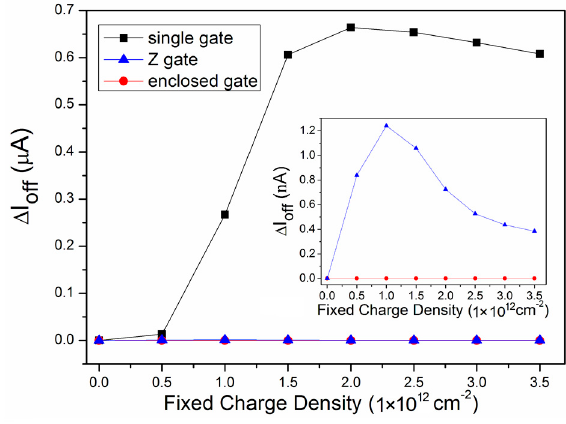
Figure 4. The leakage current increment of the three layouts at different charge densities.